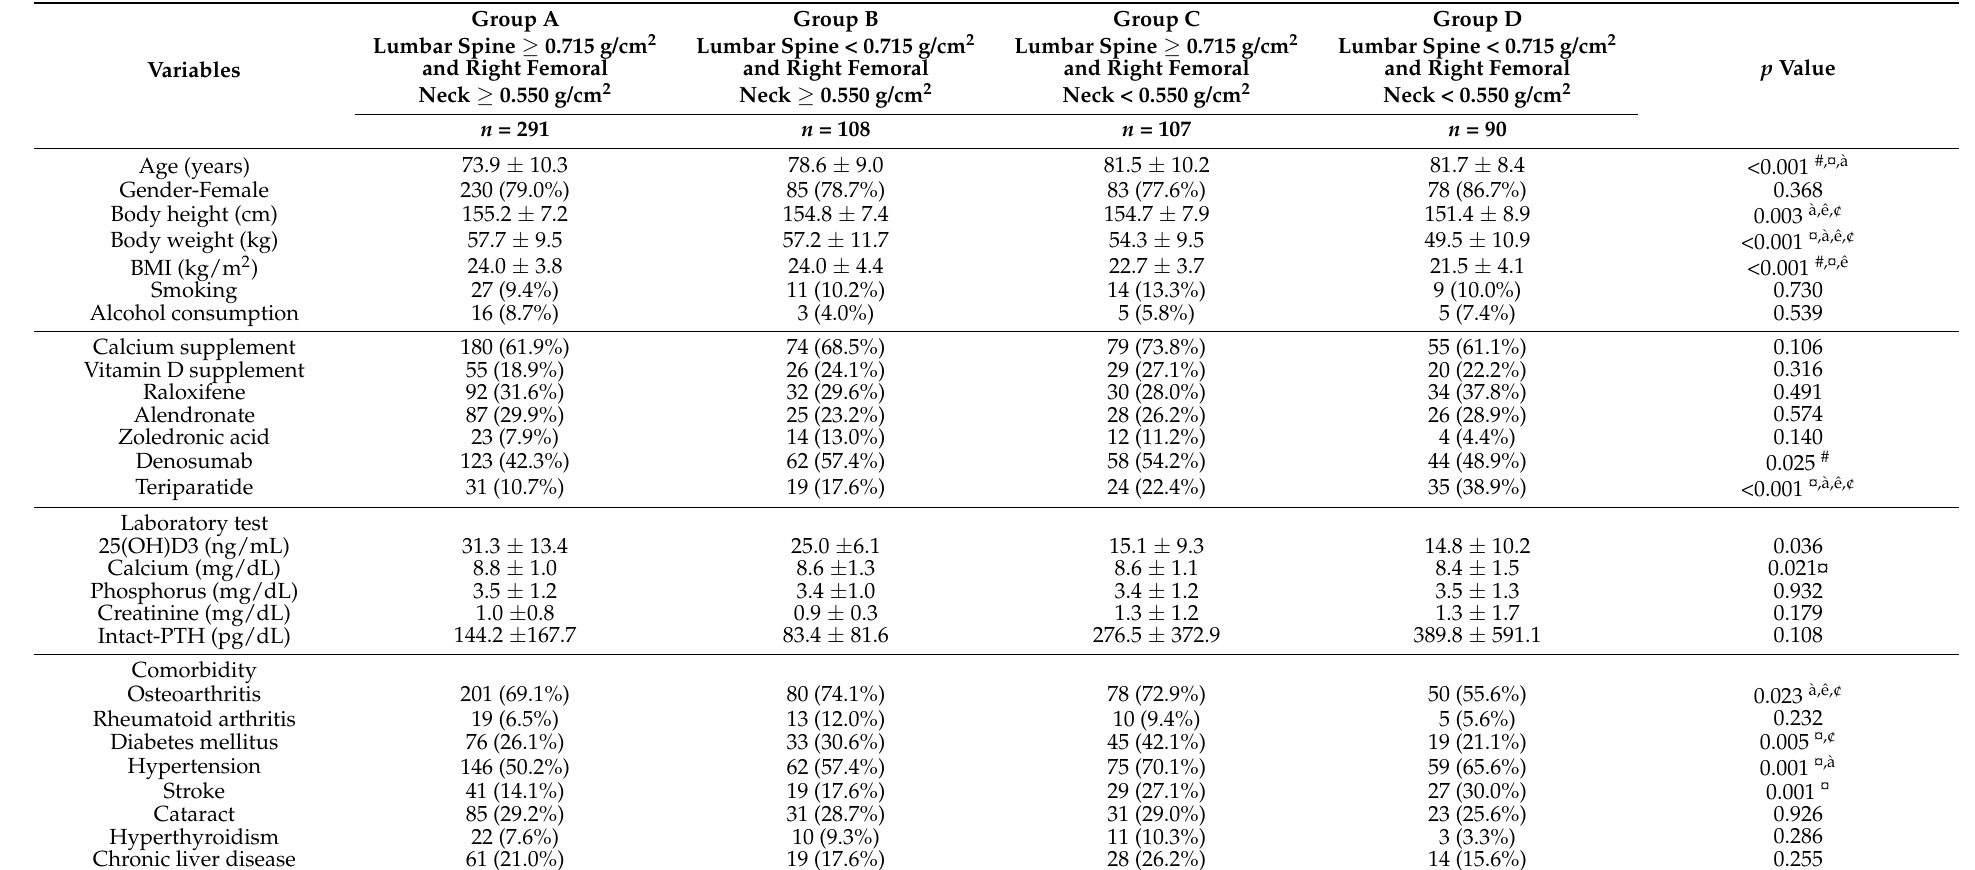
Table 1. Demographic data of participants by BMD classified according to tercile